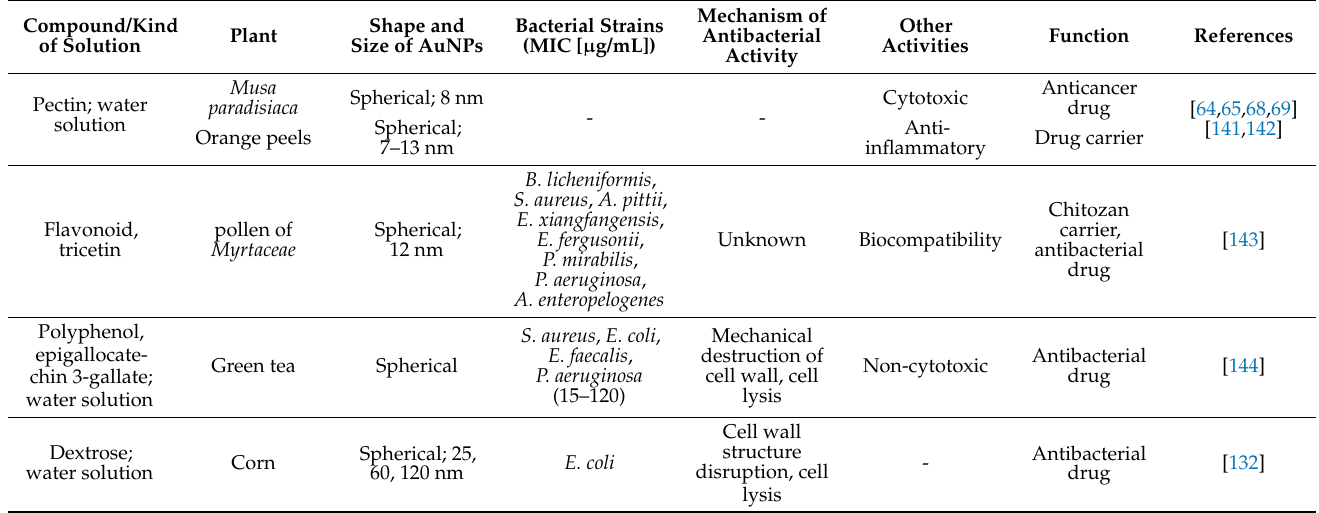
Table 3. Examples of plant compounds used in the synthesis of